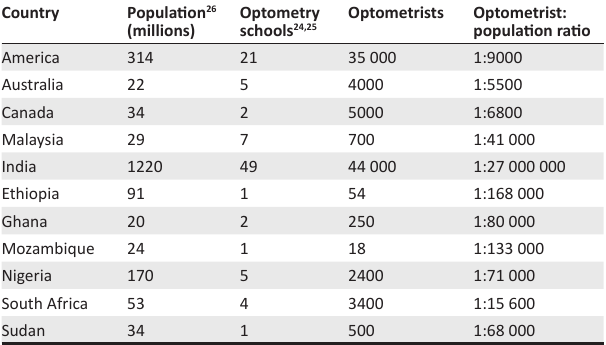
TABLE 1: Selected countries and their estimated population, number of optome- try schools, number of optometrists in the country, and optometrist:population